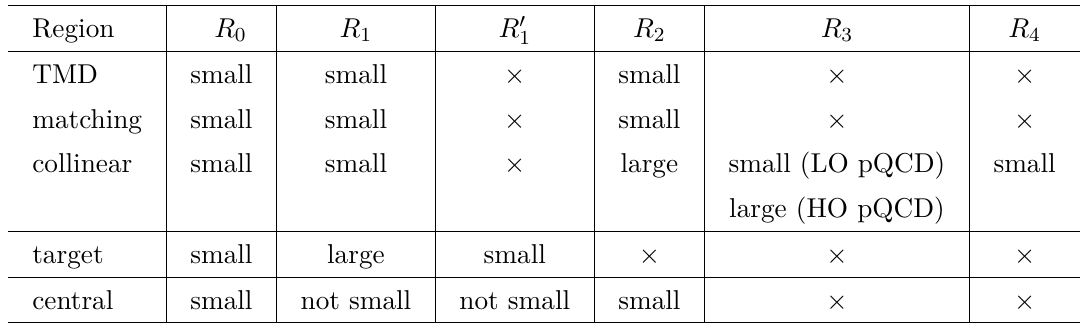
Table 2 . Examples of sizes of region indicator ratios corresponding to particular regions of SIDIS. The symbol “ × ” denotes “irrelevant or ill-defined” (see text for further